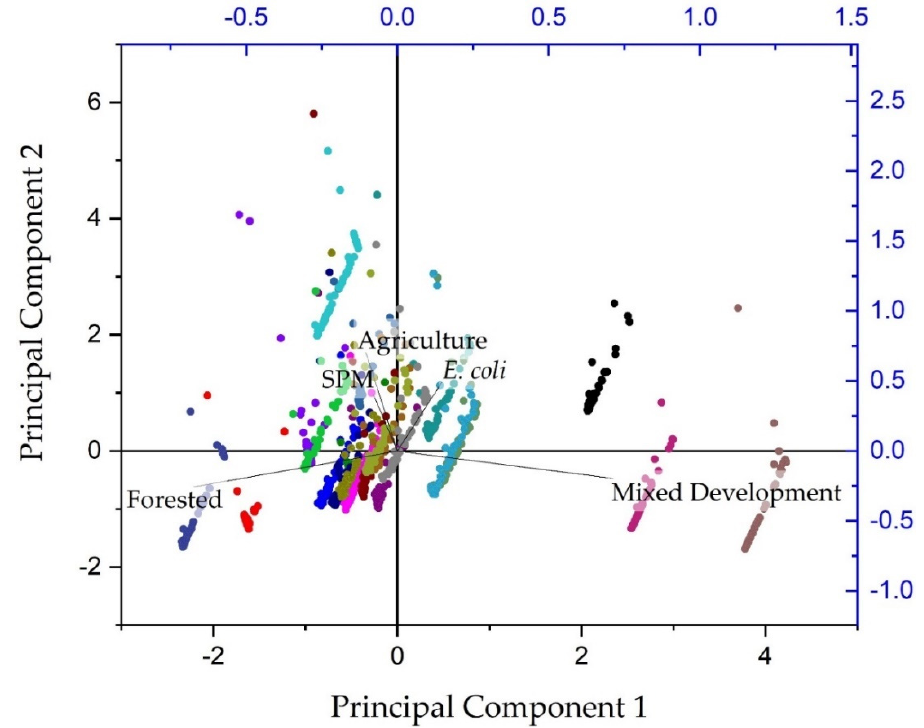
Figure 8. Results of principal component analysis, including biplots, for extracted principal components of annual E. coli concentration (CFU per 100 mL) and annual SPM concentration (mg/L) at 22 monitoring sites (indicated by the different colors) during the study period (2 January 2018–1 January 2019) in West Run Watershed, West Virginia, USA.